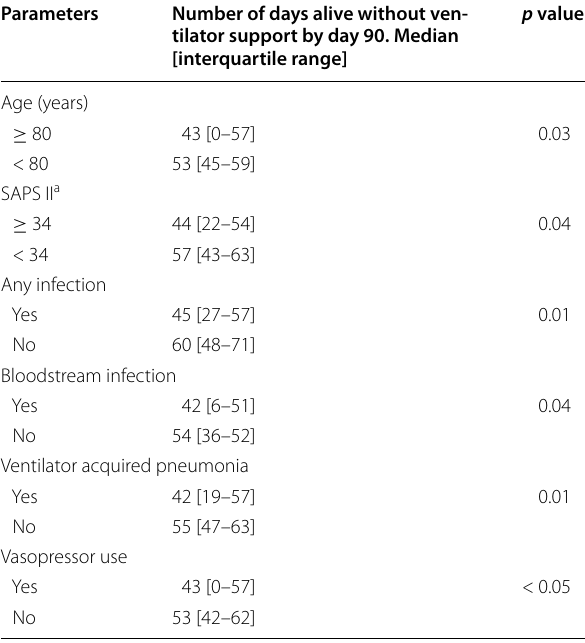
Table 3 Factors significantly associated with the